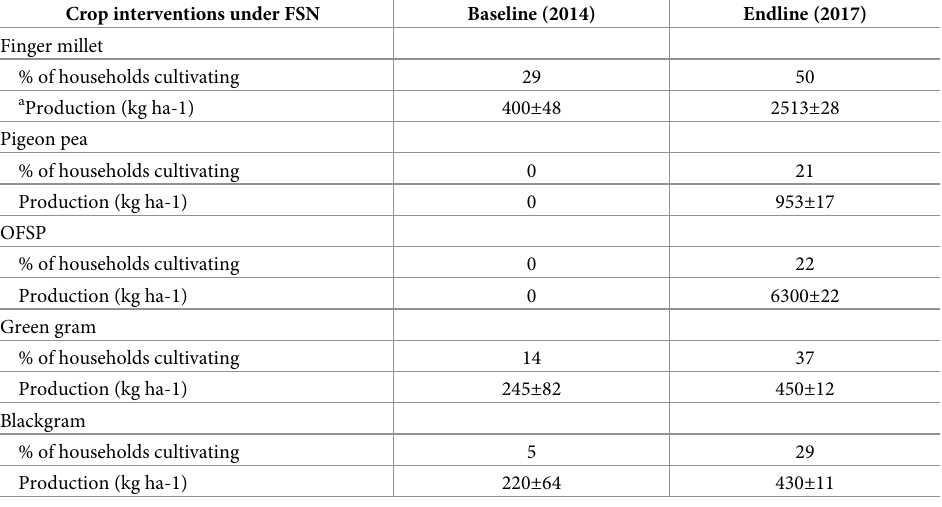
Table 3. Comparison of FSN crop interventions, cultivation and production status between Baseline and Endline, Koraput (N = 156). Crop interventions under